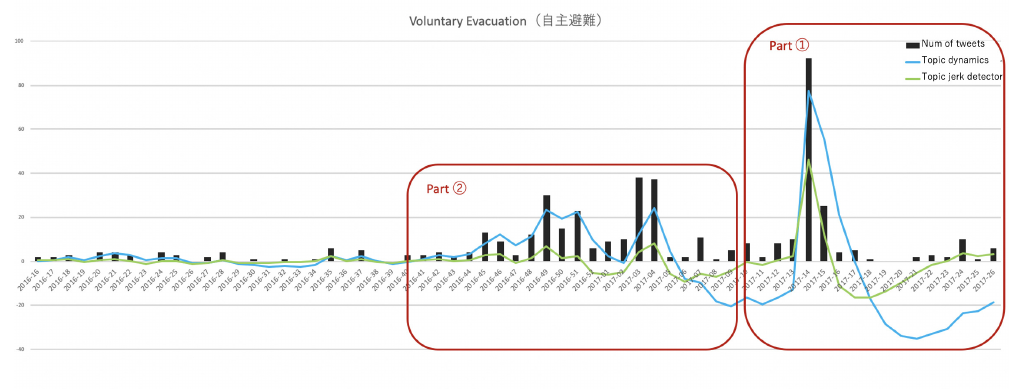
Figure 4. Comparison of models to show the topic jerk detector is a more abrupt-bursting-fit extension of topic dynamics in the case of “Voluntary evacuation”. The green curve shows the values calculated by the topic jerk detector, the blue ones correspond to topic dynamics, and the black bars are the number of tweets for each week.